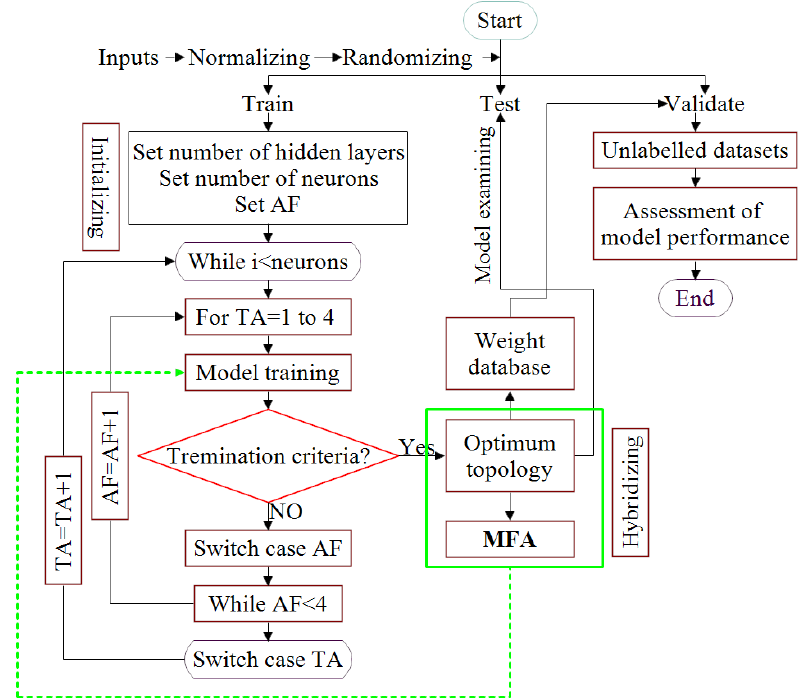
Figure 3. Block diagram of developed adaptive hybridized multitask learning procedure to capture the optimum topology.